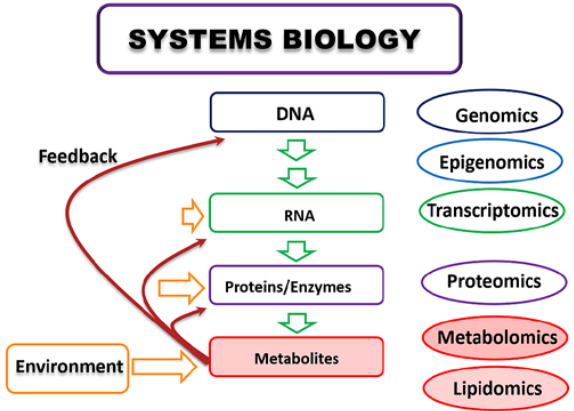
Figure 3. Systems Biology hierarchy depicts systems environmental impact and connections with upstream processes.